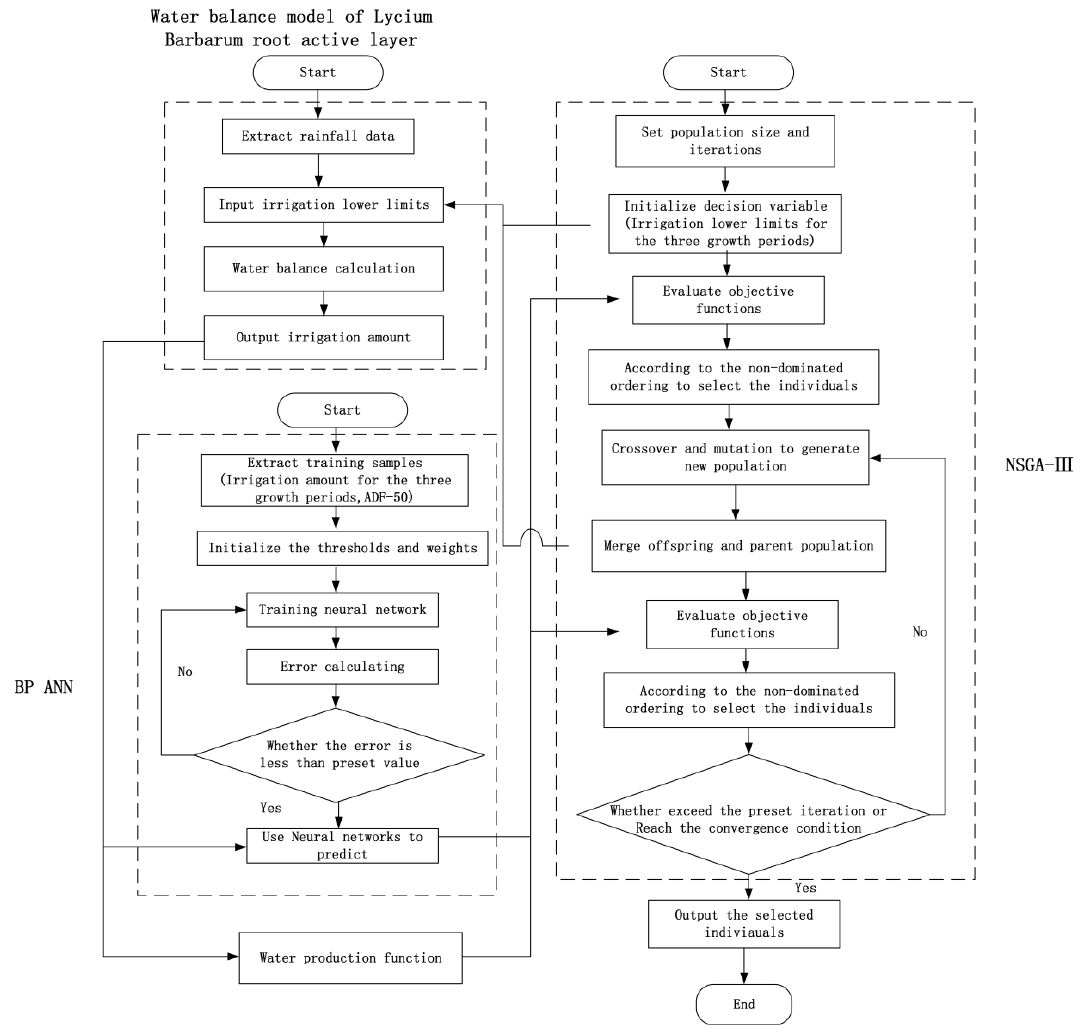
Figure 3. Construction flow chart of the coupling model.